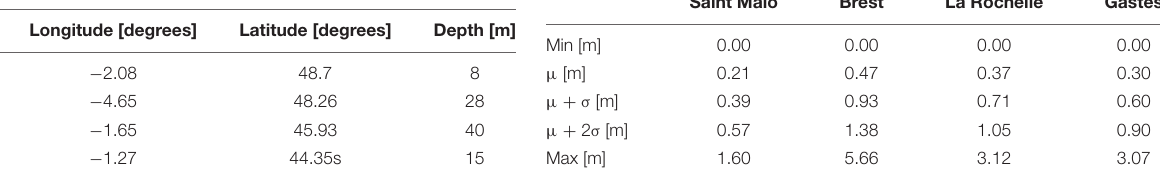
TABLE 3 | Location and water depth of the French Gauges chosen for meta-model construction.